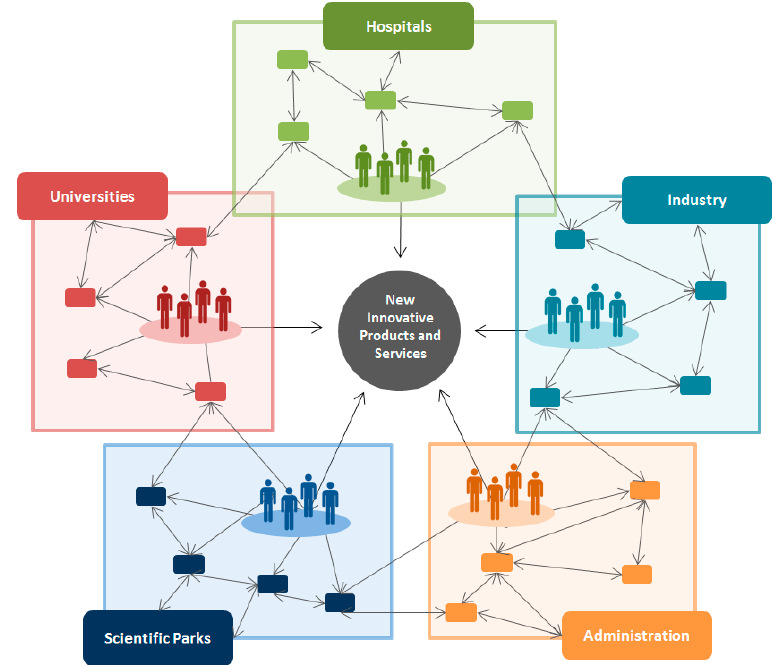
Figure 7. Scheme of a multidisciplinary ecosystem of stakeholders collaborating in the development of emergent devices (inspired from [144]).